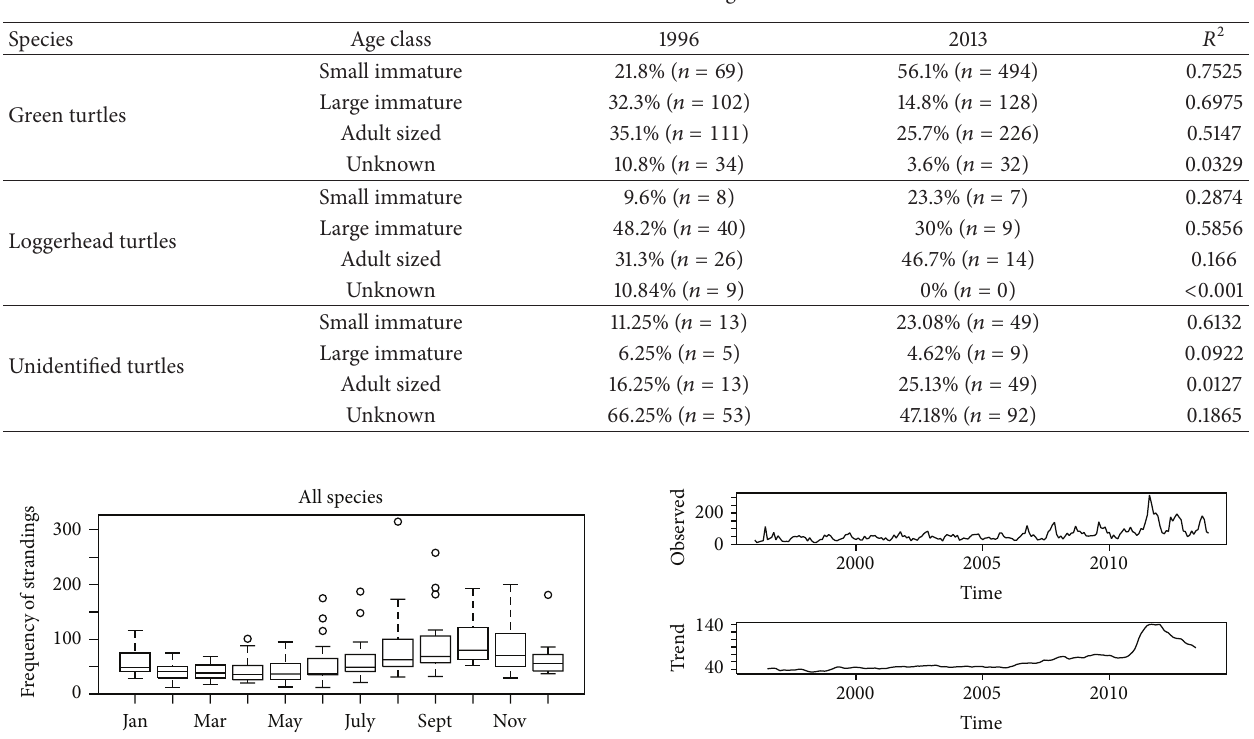
Figure 3: Boxplot of total monthly stranding values.